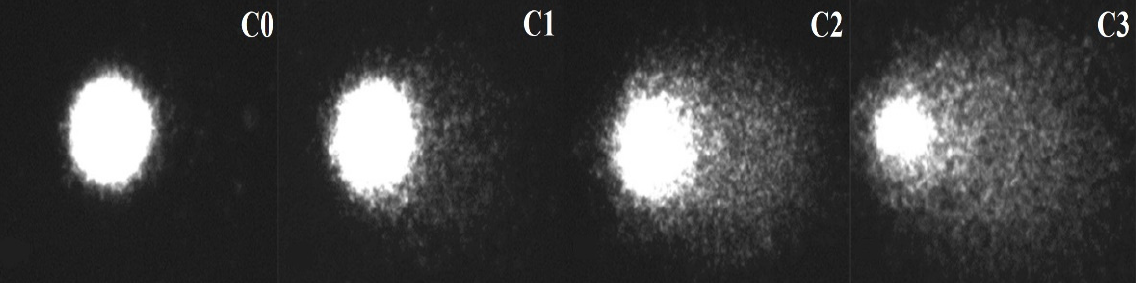
Figure 1. Comet images of the sperm S. mirabilis for different DNA damage classes.